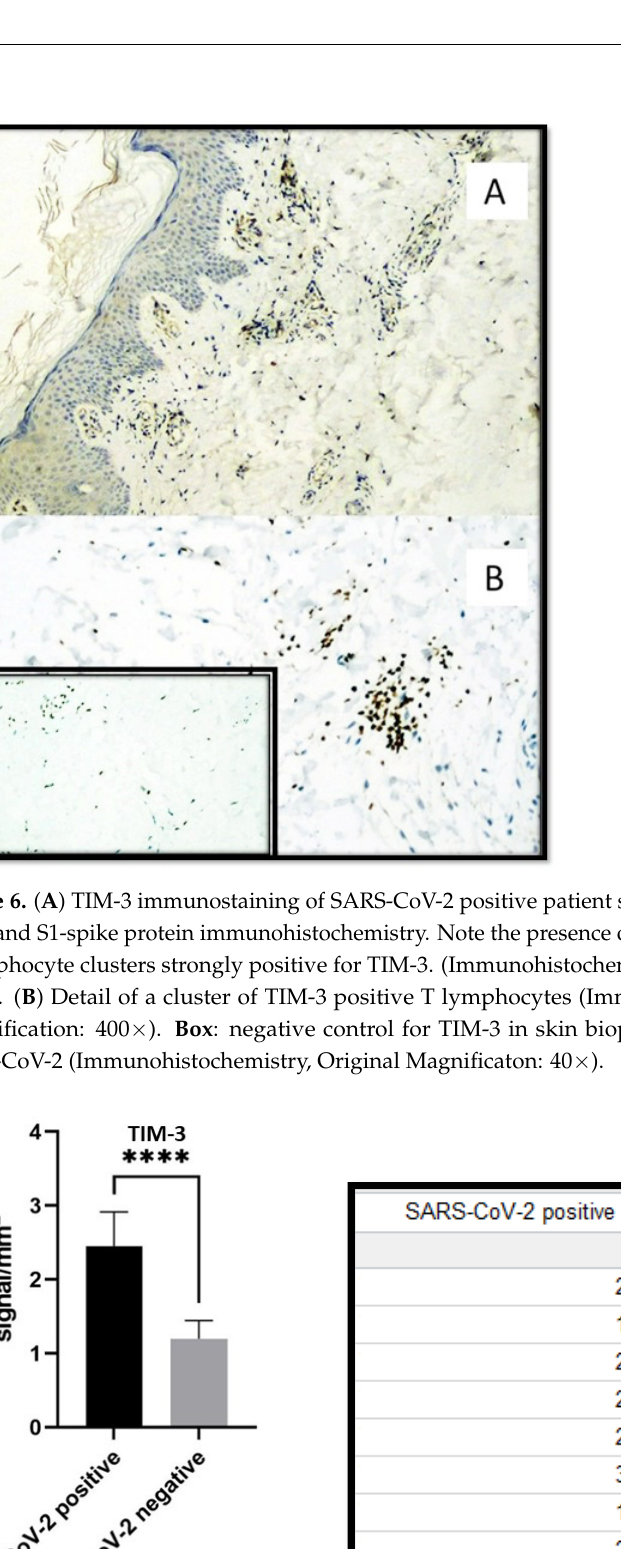
Figure 5. Different levels of HMGB1 immuno-expression in the two study populations. Note that there was statistically significant difference ( p value < 0.0001, <0.05). The signal was calculated in a semi-quantitative way as reported in the paragraph “Material and Methods”. **** statistic significative.